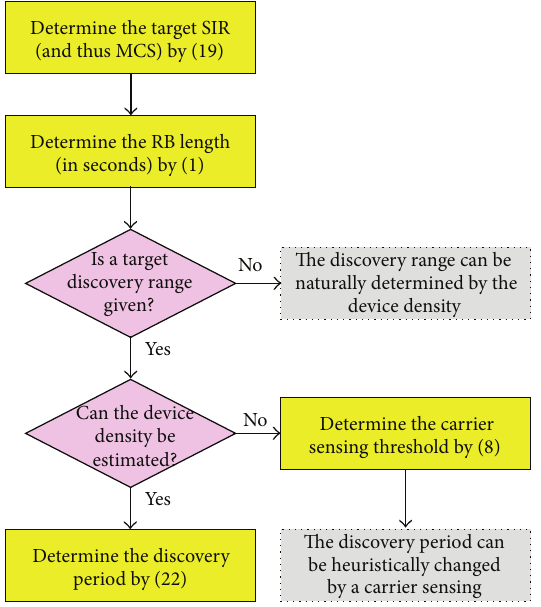
Figure 4: Optimization framework for discovery